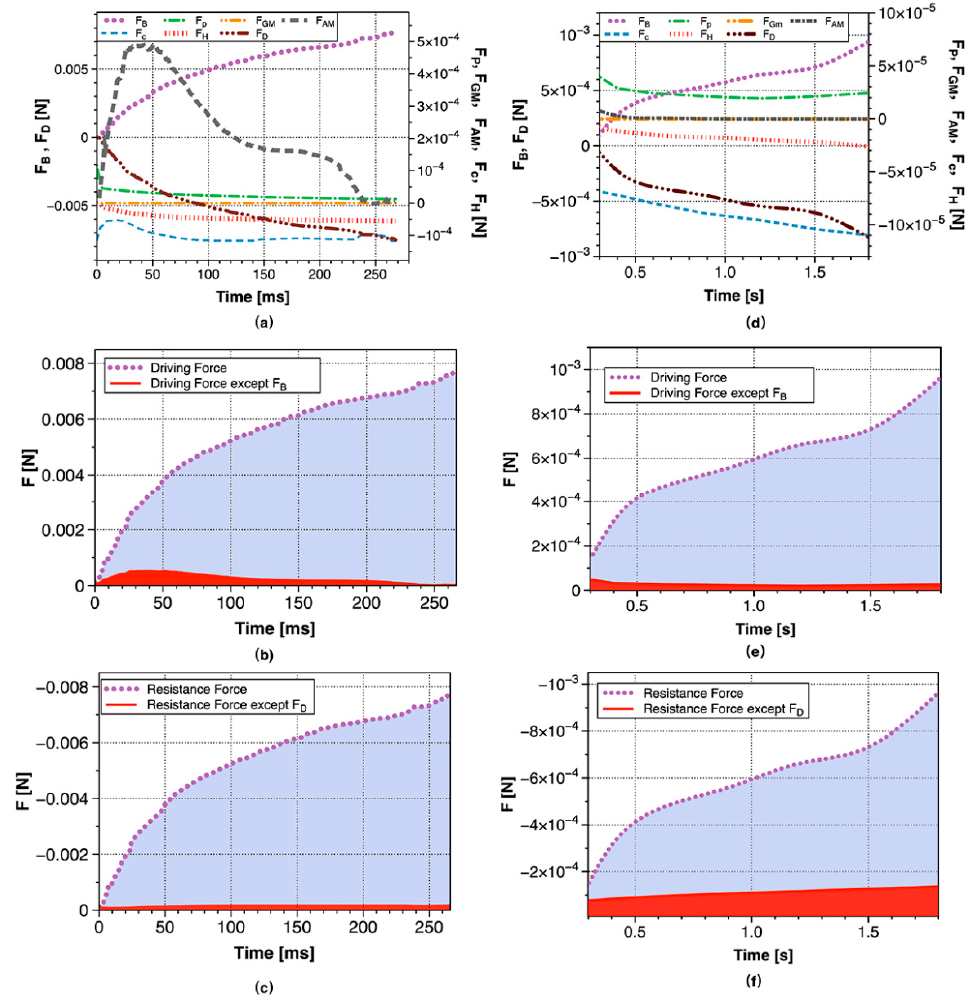
Figure 13. Curves of various forces with time in the major bubble growth ( a – c ) and minor bubble growth ( d – f ).